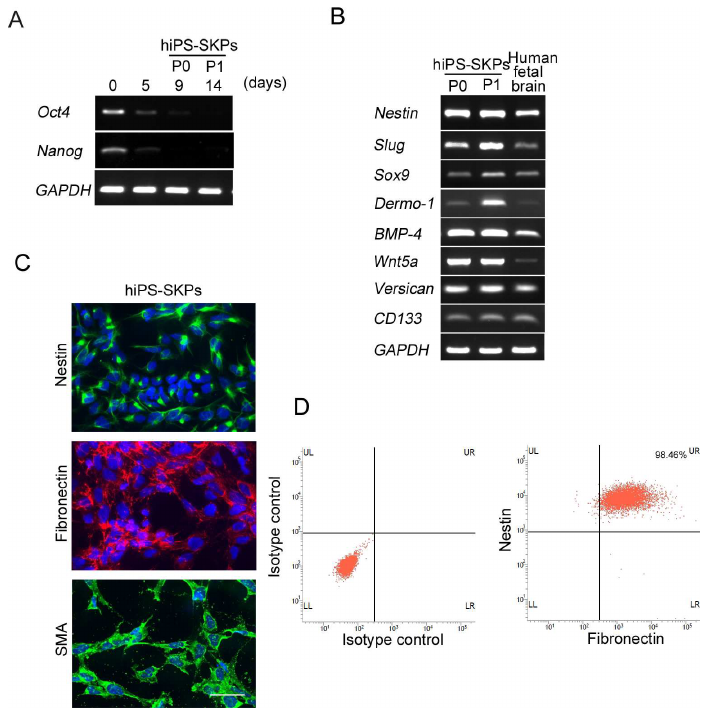
Fig 4. Molecular characterization of hiPSCs-derived SKPs. (A) RT-PCR analysisof genesexpressedby hiPSCs, and (B) hSKPs in total RNAs from hiPSCs duringdifferentiation. RNA from human fetal brain serves as a positive control, while GAPDH is used as a loadingcontrol. (C) Immunocytochemical analysisof nestin, fibronectin and α -SMA in hiPSCs-derived SKPs. Scale bar, 100 μ m. (D) Flow cytometric analysisof hiPSCs- derived SKPs to detect the number of nestin and fibronectin positive